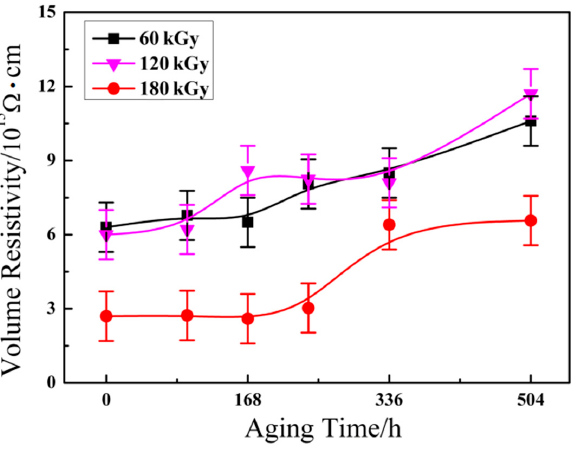
Figure 9. The effect of aging time on the volume resistivity of ETFE at various